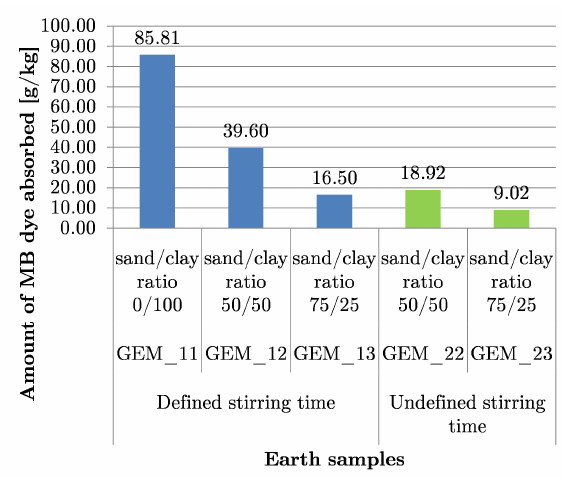
Figure 7. Resulting values of amount of MB solution